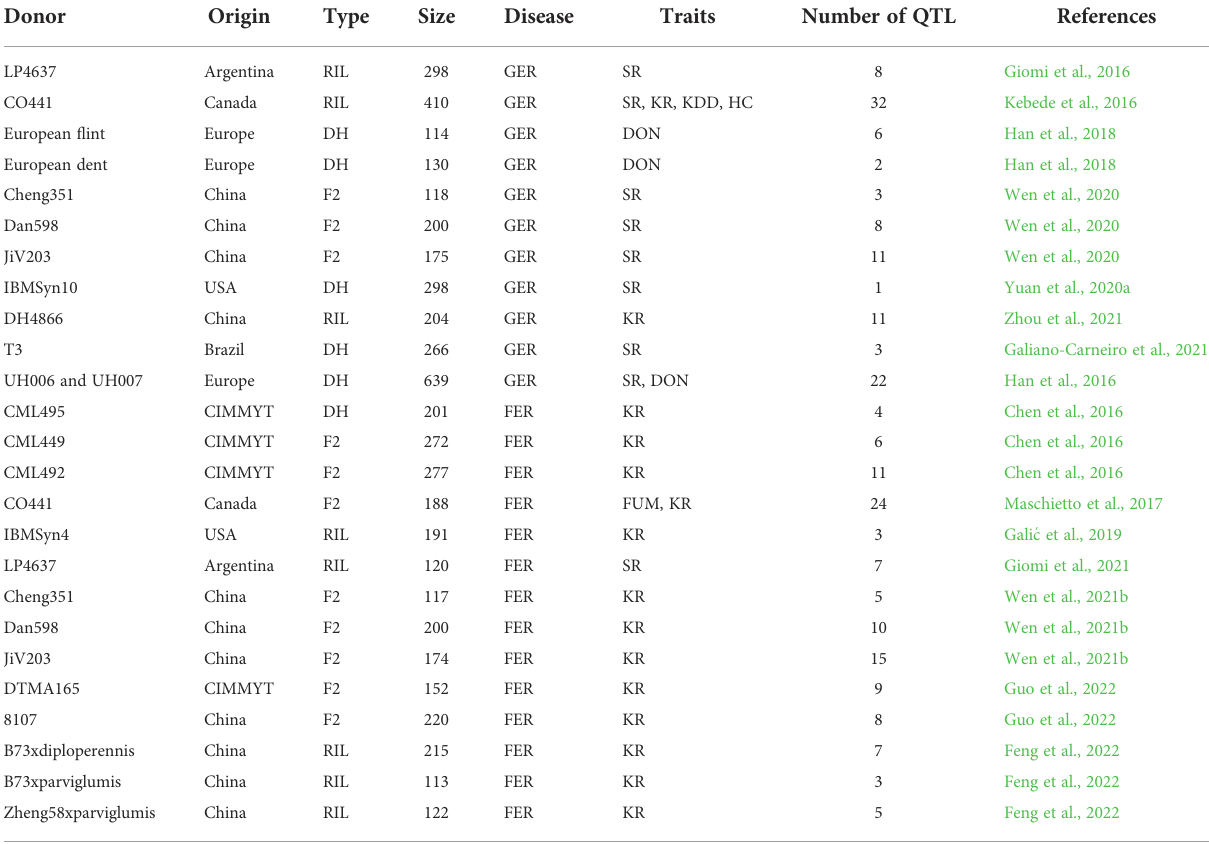
TABLE 2 Characteristics of SNP-based QTL mapping studies on resistance to Fusarium (FER) and Gibberella ear rot (GER) analysed in this study.